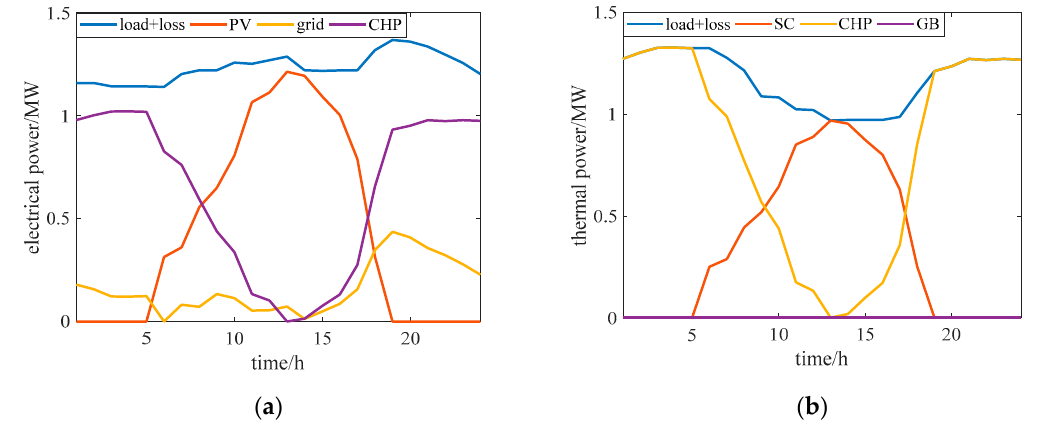
Figure 6. ( a ) Electrical power output in Case 2.1; ( b ) thermal power output in Case 2.1.